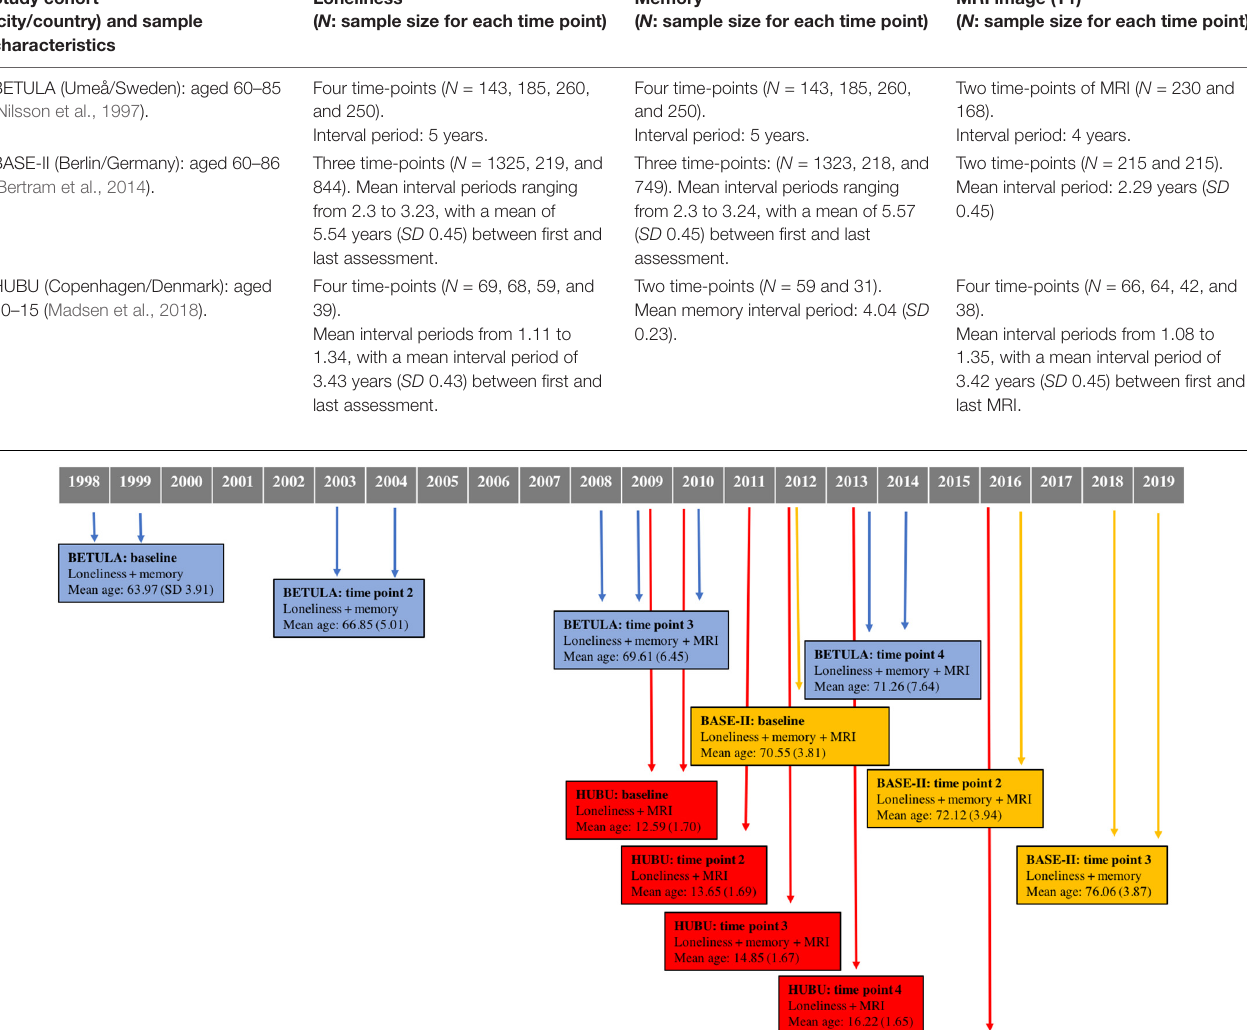
Loneliness ( N : sample size for each time point) Four time-points ( N = 143, 185, 260, and 250). Interval period: 5 years.